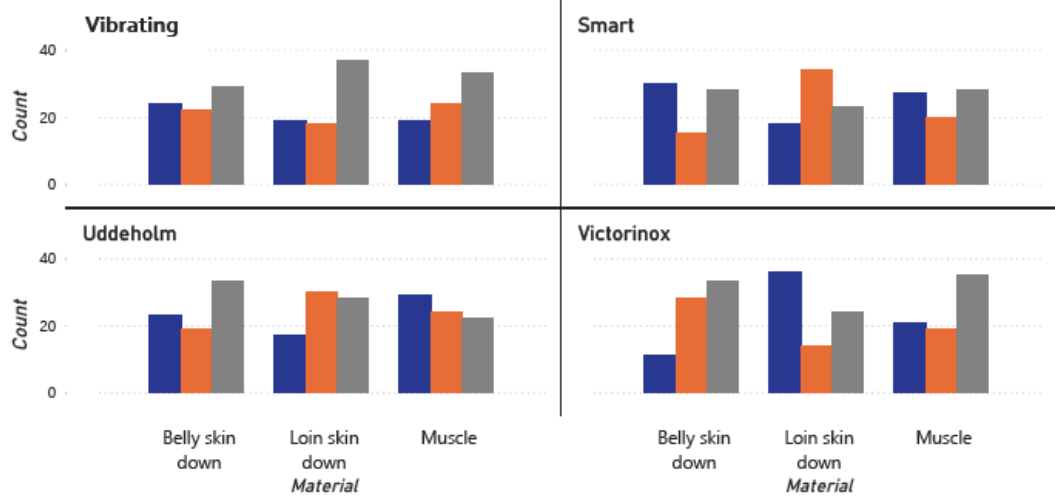
Fig. 4. Respondents’ classifications on whether various pork cuts (horizontal axis) were made by a professional butcher or a robot. Score 1 = cut by a butcher, 2 = cut by a robot, 3 = can’t tell For each of the 76 respondents, the number of correct answers to this question was counted. The correct response value represents the total counts of correct assessed images regarding manual or robot cutting. The Victorinox knife received an average acceptance score of 1.3 with 68 correct responses out of 224 total assessments. The Uddeholm knife received an average acceptance score of 1.68 with 73 correct responses out of 228 total assessments. The vibrating knife received an average acceptance score of 1.19 with 64 correct responses out of 227 total assessments. The Smart knife received an average acceptance score of 1.49 with 69 correct responses out of 227 total